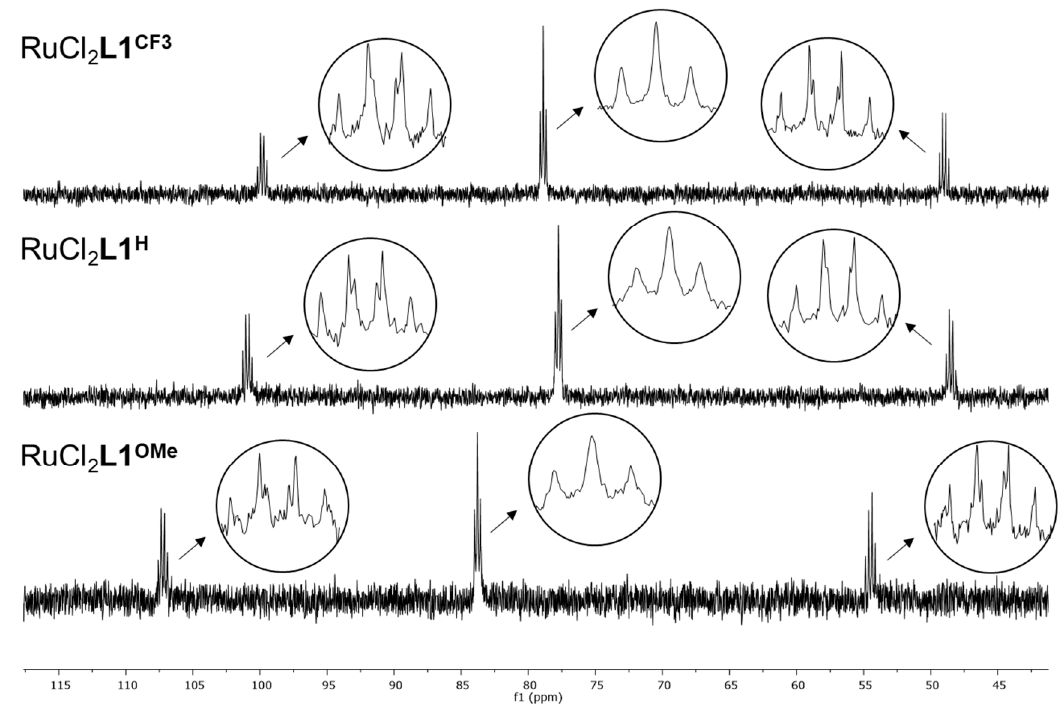
Figure 3. 31 P-NMR spectra of L1 R -based ruthenium(II) dichlorido complexes.